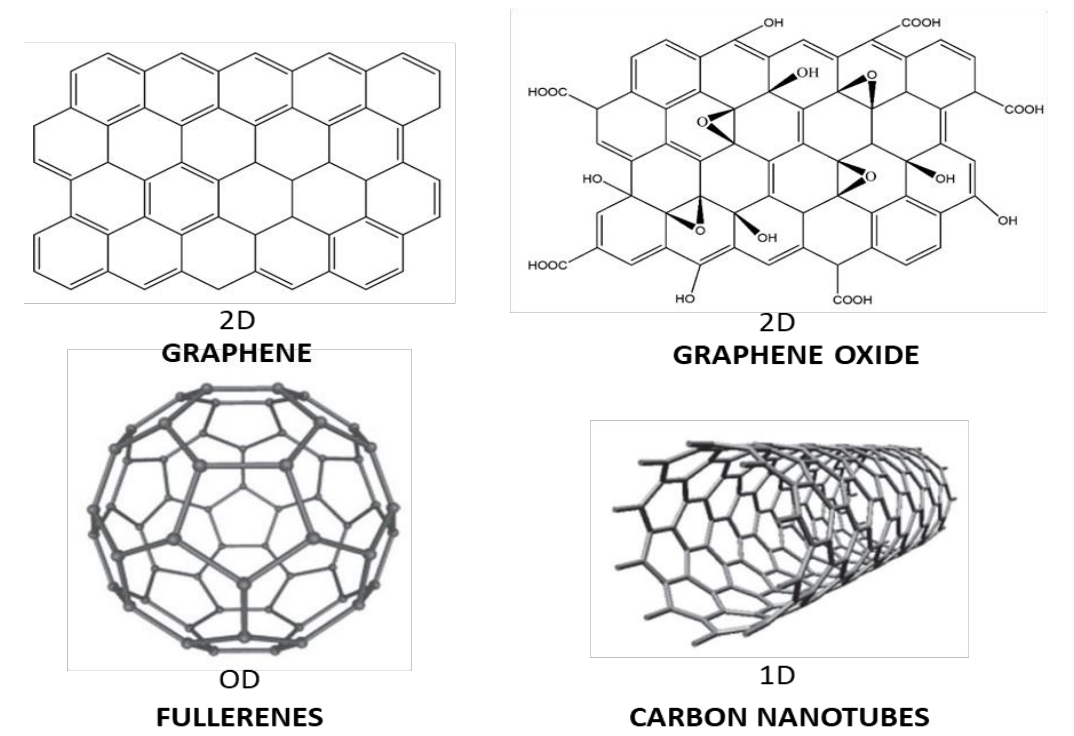
Scheme 1. Chemical structure of carbon nanomaterials: 2D graphene and its derivative graphene oxide (GO), 0D fullerenes, and 1D carbon nanotubes (CNTs).